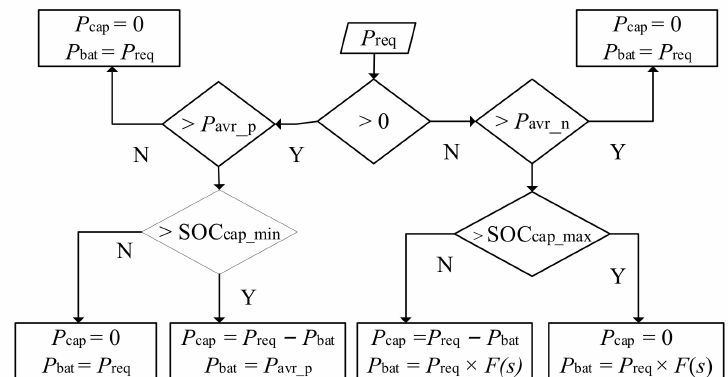
Figure 3. Flowchart of the logic threshold control